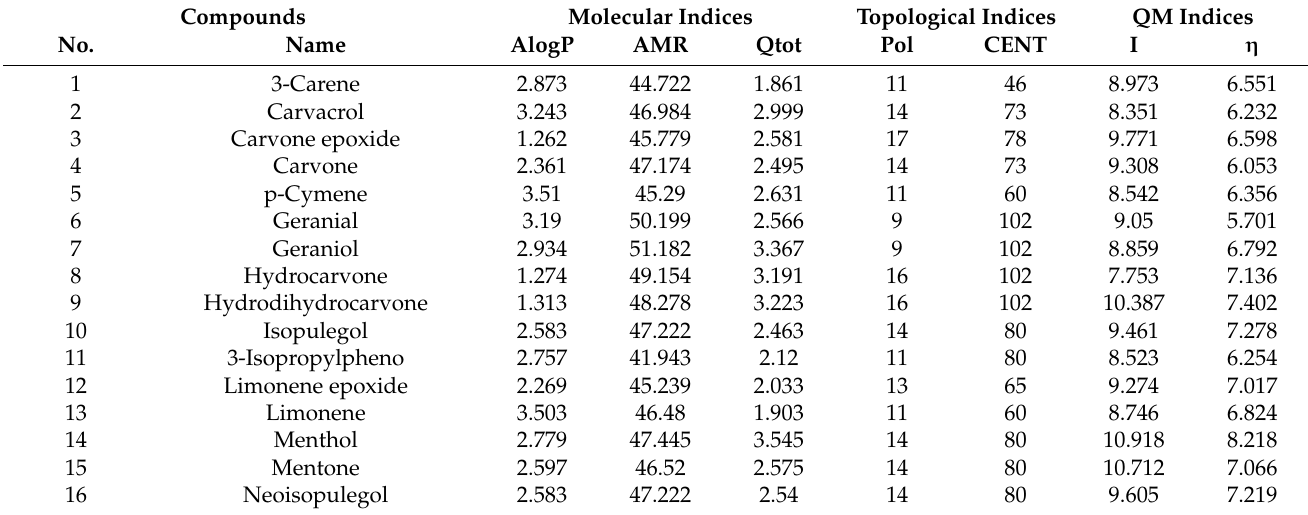
Table 4. Physicochemical parameters used to derive QPAR